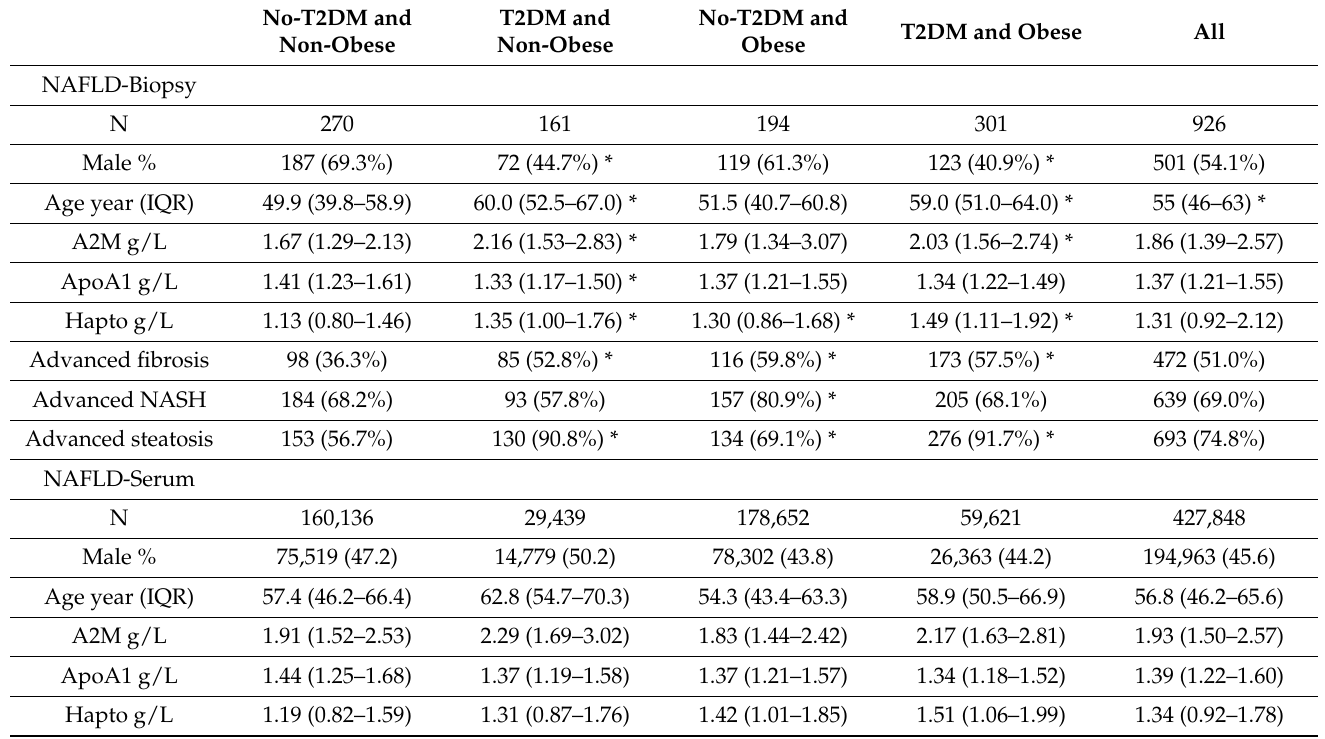
Table 1. Characteristics of “NAFLD-Biopsy” and NAFLD subsets according to diabetes and obesity. * = Significant vs. No-T2DM and Non-Obese subset.